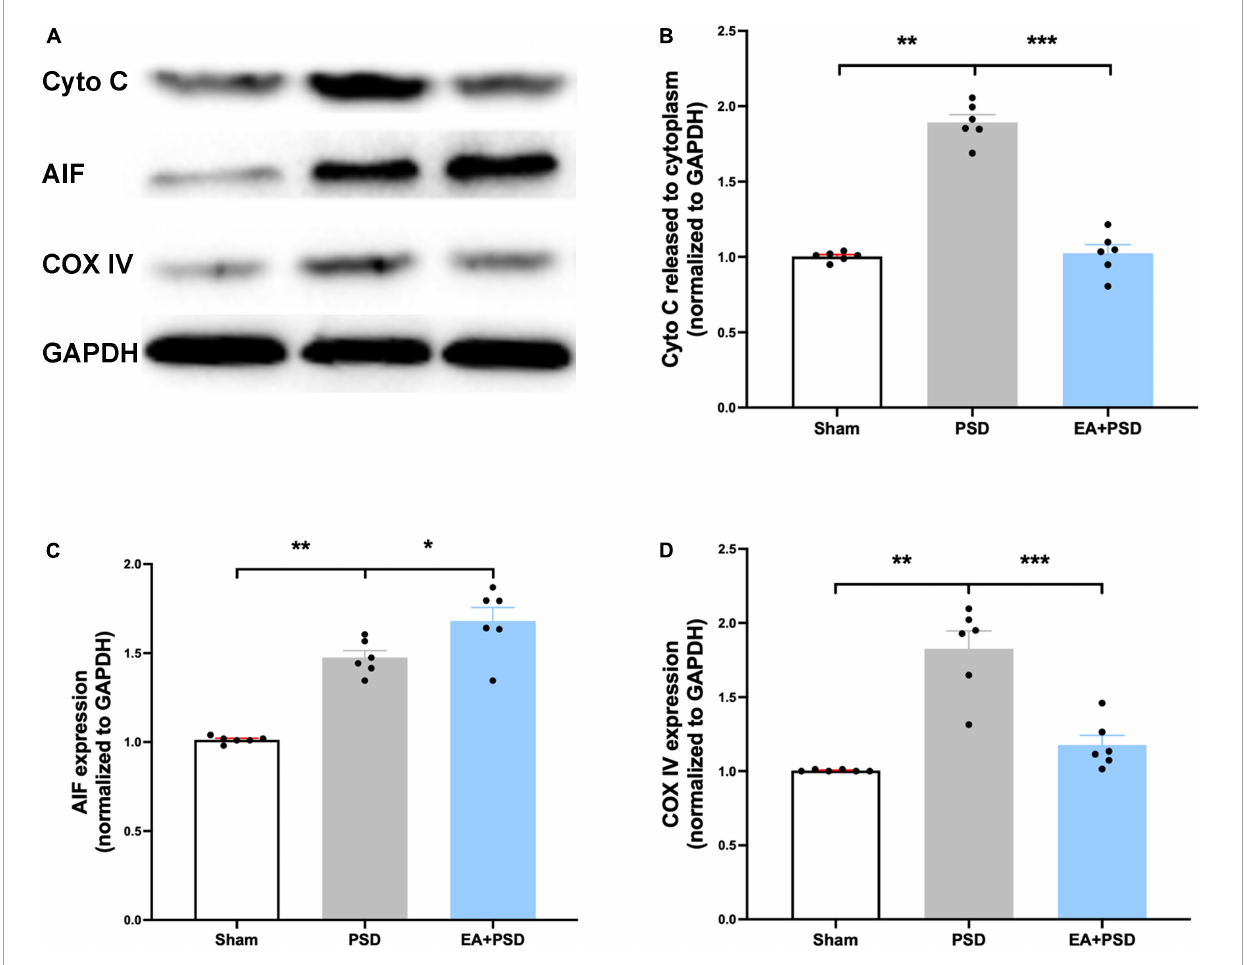
FIGURE4 EA treatment ameliorated the mitochondrial dysfunction produced by PSD. (A) Representative images of western blot bands of cytochrome C and COX IV protein. (B–D) Quantitative changes in cytochrome C (B) , AIF (C) and COX IV (D) in the hippocamps ( n = 6, ** P <